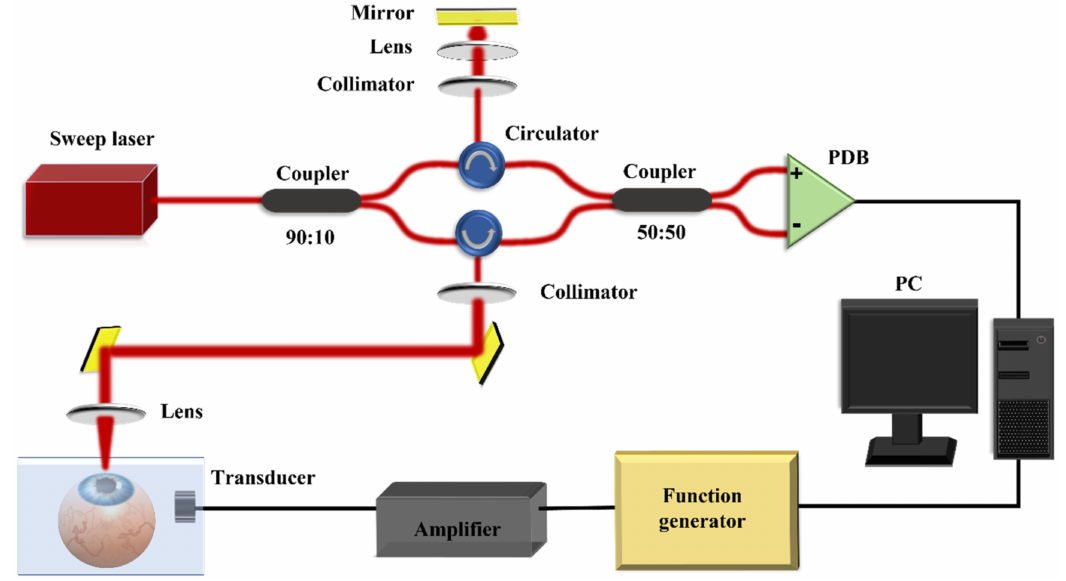
Figure 1. The schematic of the ARF-OCE